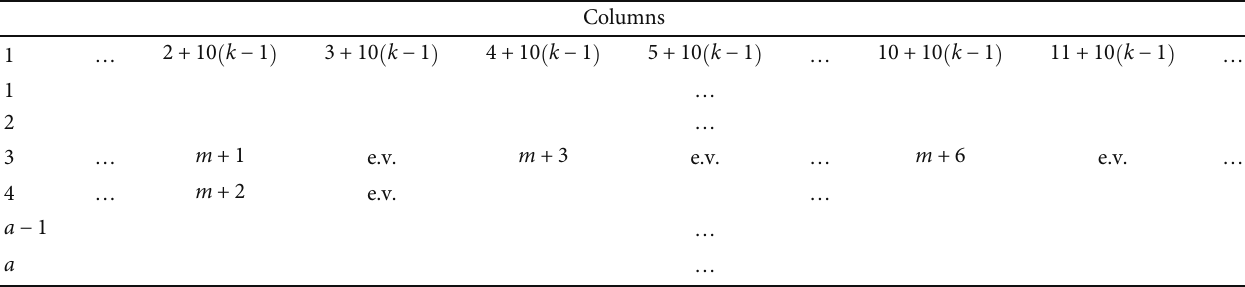
Table 3: Numbering scheme for the node-numbering matrix for the k th crack.